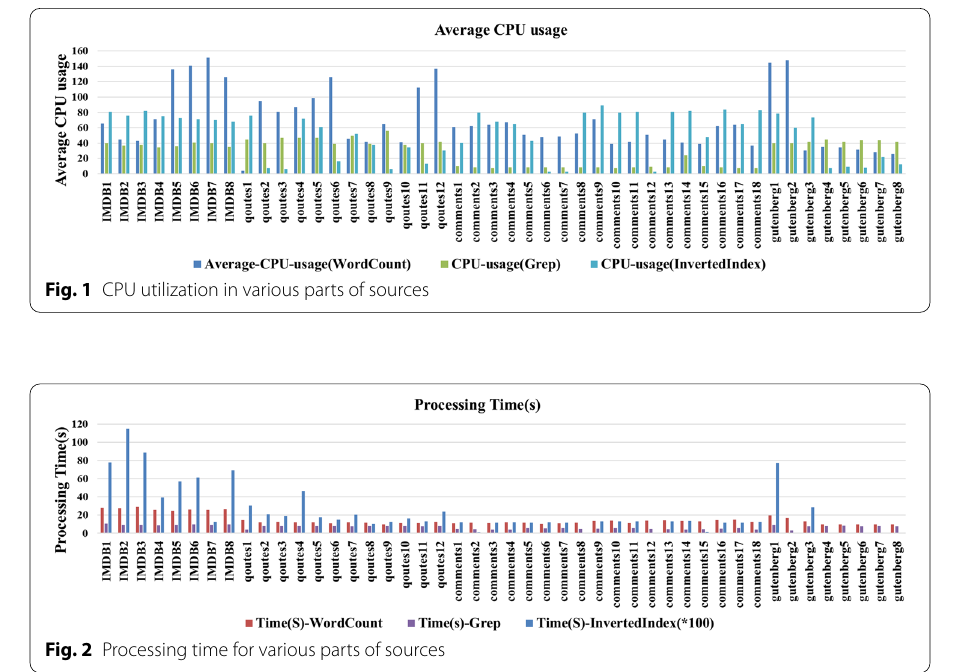
Fig. 2 Processing time for various parts of